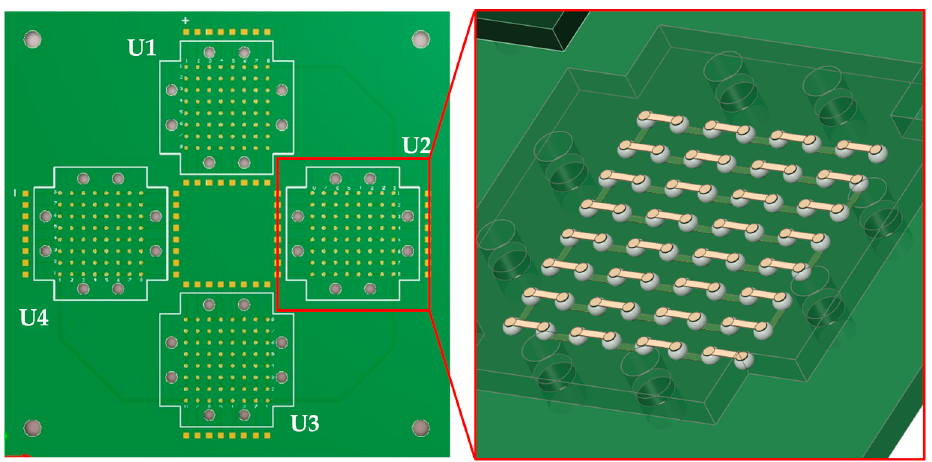
Figure 1. The design of test board and layout.